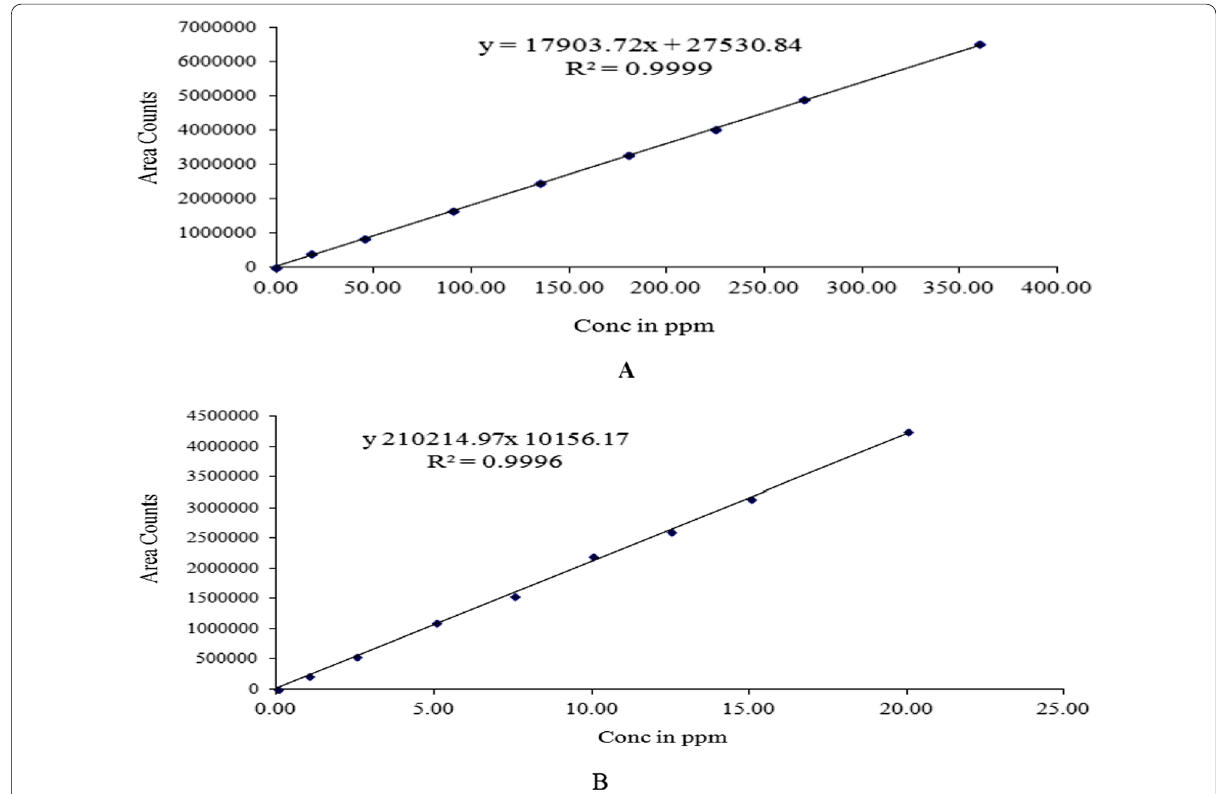
Fig. 4 Linearity plots of A Bempedoic acid and B Ezetimibe